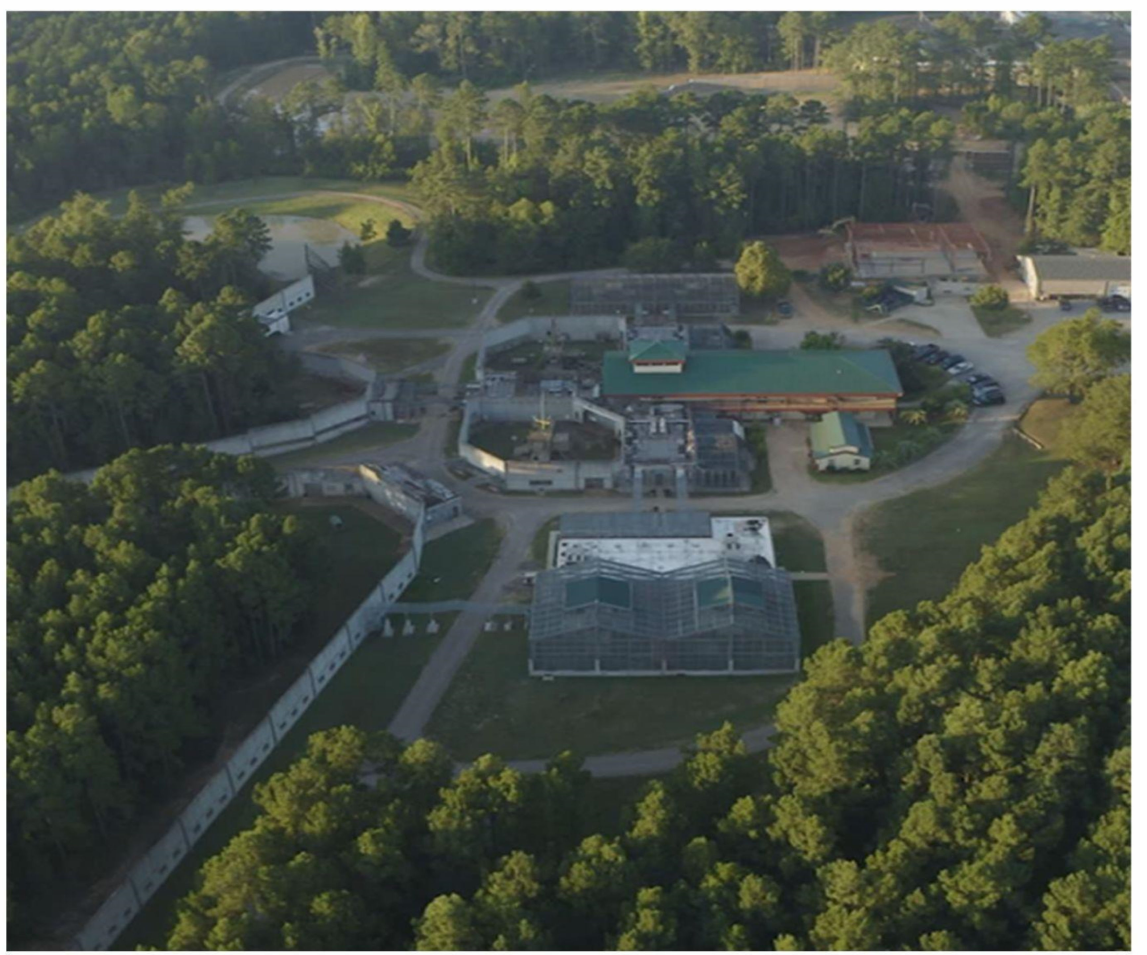
Figure 1. An aerial drone photo of Chimp Haven showing two open topped corrals in the middle of the photo and closed topped enclosures with brachiation bars at the top and bottom of the photo. Sections of Chimp Haven’s three multi-acre forested habitats are shown on the left side of the